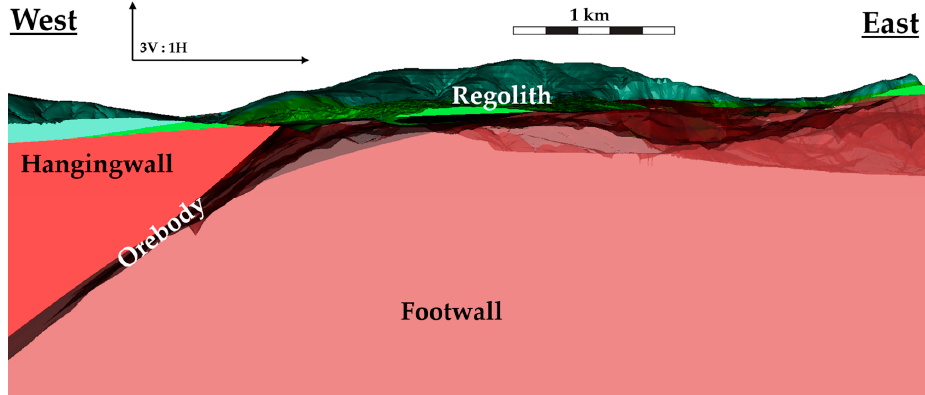
Figure 3. Cross-section of the 3D geological model of the Paracatu lithology looking north with a vertical exaggeration (VEX) of 3:1. Perspective thickness includes north to south extent of mine site. Footwall is shown as transparent to illustrate the orebody and overlying regolith.